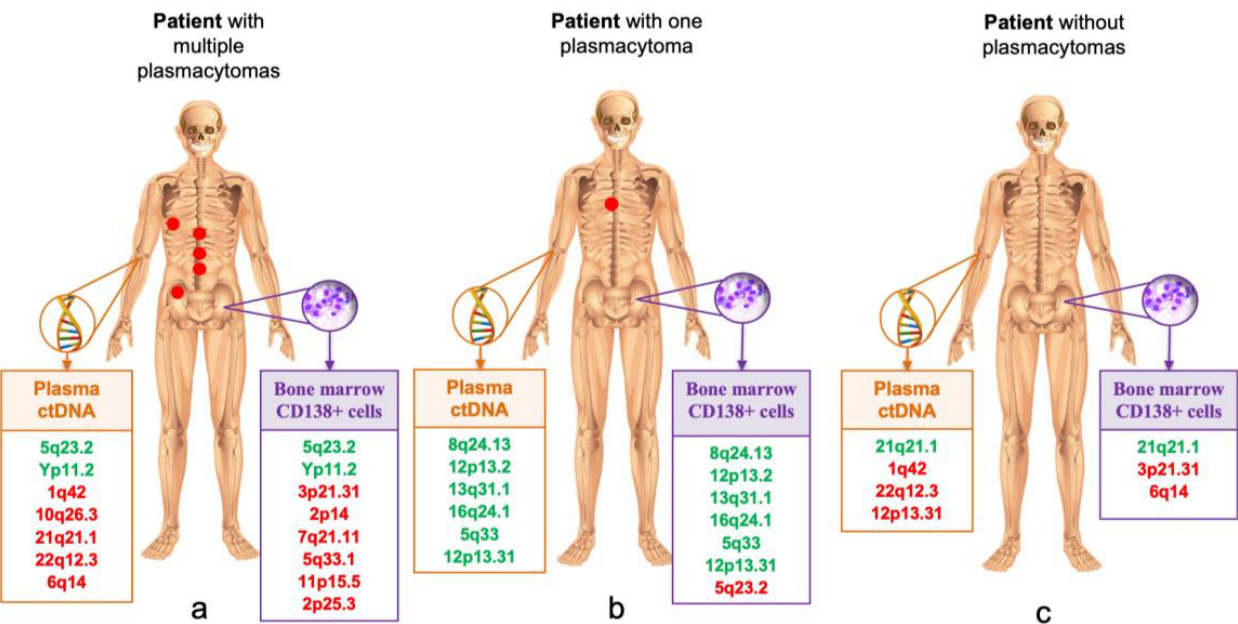
Figure 4. Comparison of STR profiles in plasma ctDNA and CD138+ bone marrow cells in MM